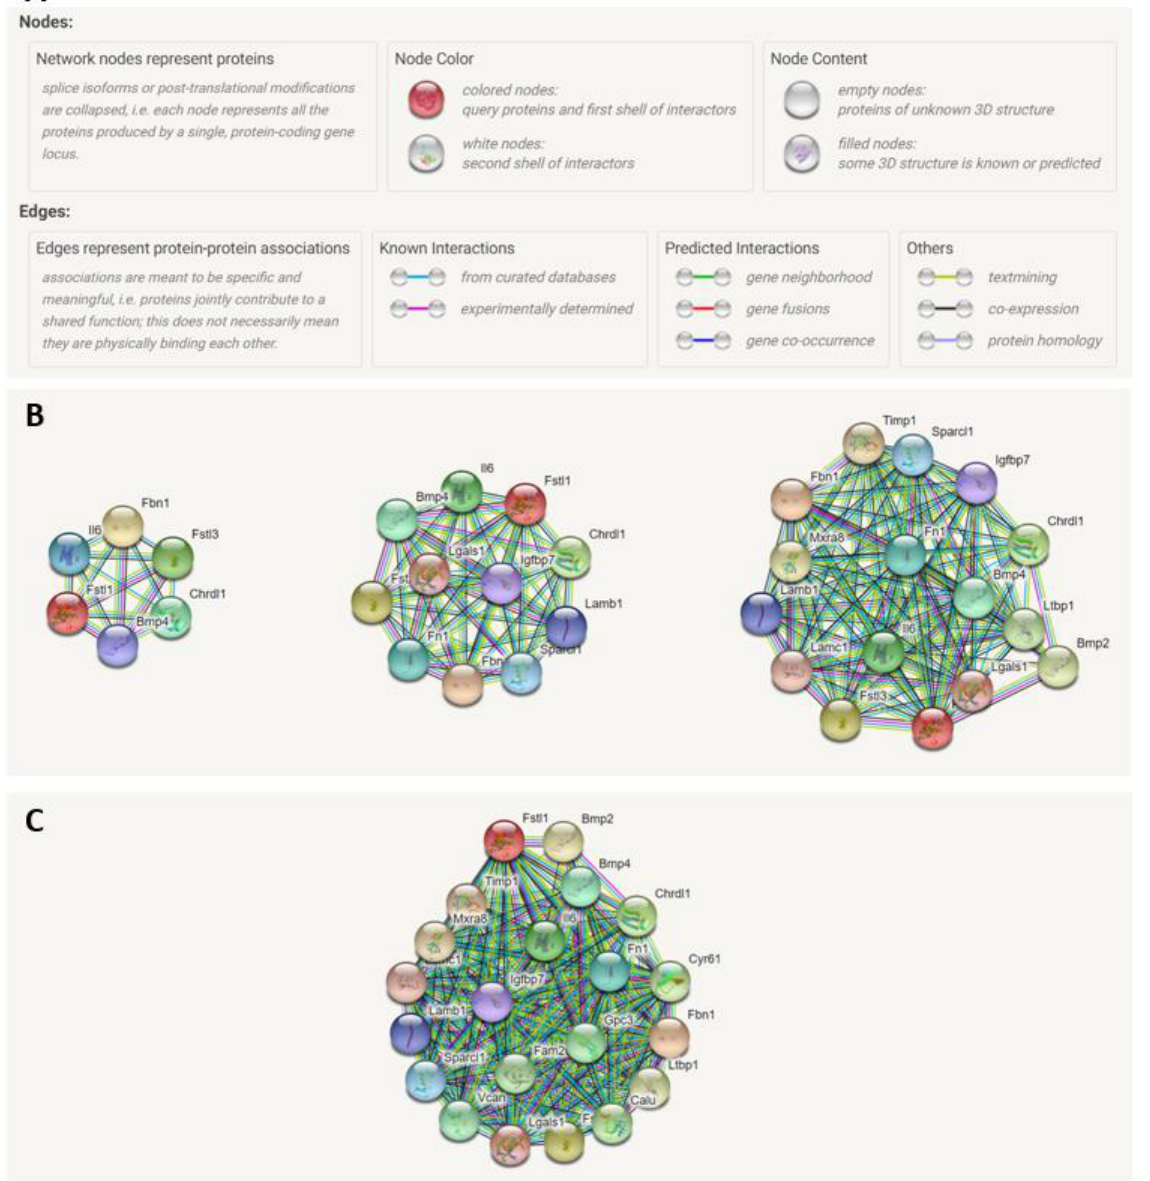
Figure 14. Protein–protein interaction (PPI) analysis of FSTL1. ( A ) Descriptions of nodes and edges used in the PPI interaction map. ( B ) STRING interaction map showing protein–protein association between FSTL1 and 5, 10, and 15 proteins. ( C ) STRING interaction map showing protein–protein association between FSTL1 and 20 proteins (listed in Figure 15 with the confidence scores generated by STRING).